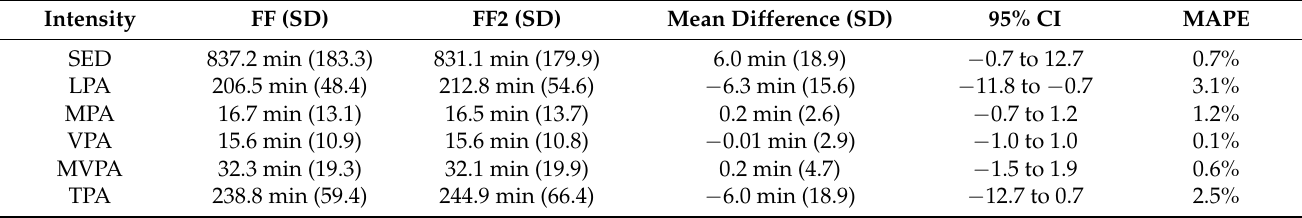
Table 2. Mean differences and Mean Absolute Percent Errors (MAPE) of SED and PA between FF and FF2.